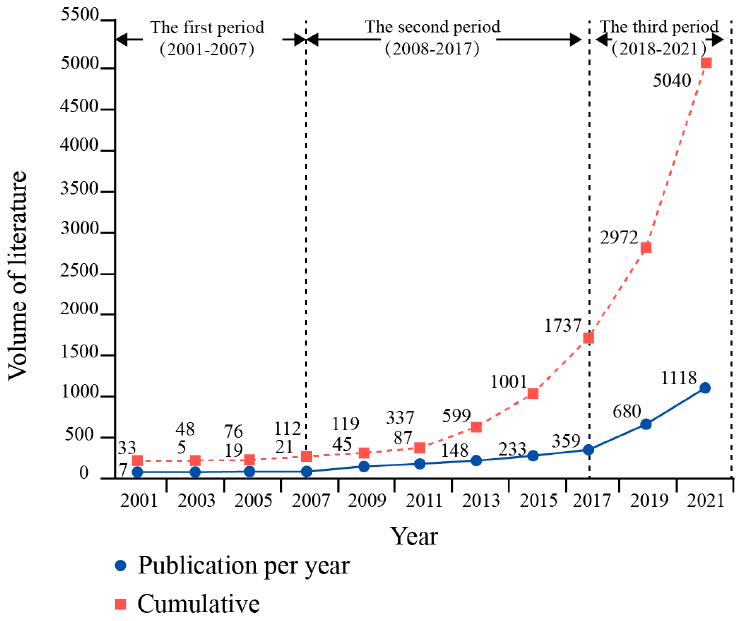
Figure 1. Number of research articles from 2001 to 2021.